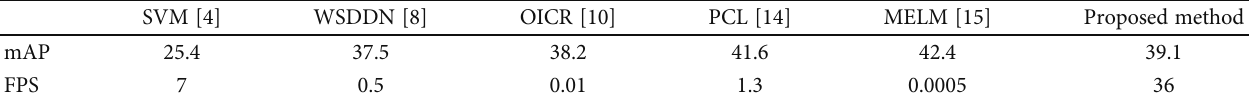
Table 3: mAP and detection speed results on PASCAL VOC 2012